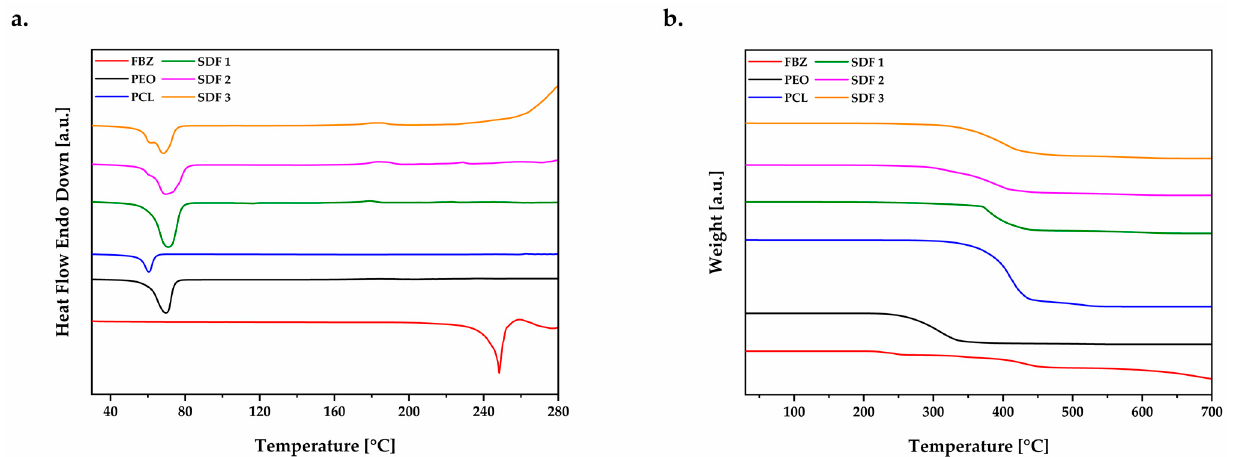
Figure 4. ( a ) DSC and ( b ) TGA thermograms of FBZ, PEO powder, PCL powder, SDF 1, SDF 2, and SDF 3.